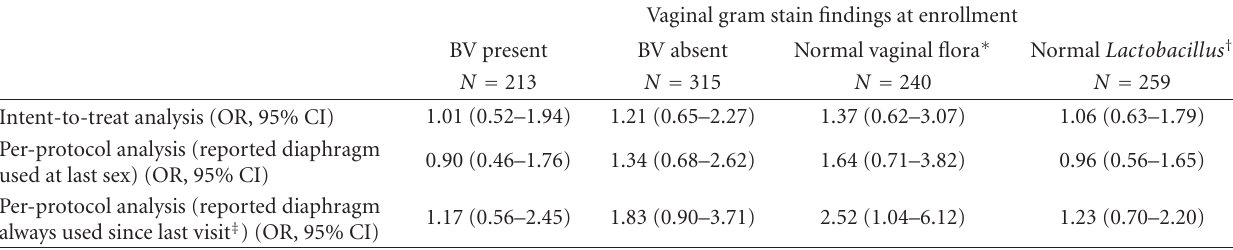
Table 2: The odds of prevalent bacterial vaginosis (BV) during followup in participants randomized to intervention compared to control arms, stratified by presence and absence of BV, normal vaginal flora, and normal lactobacillus at